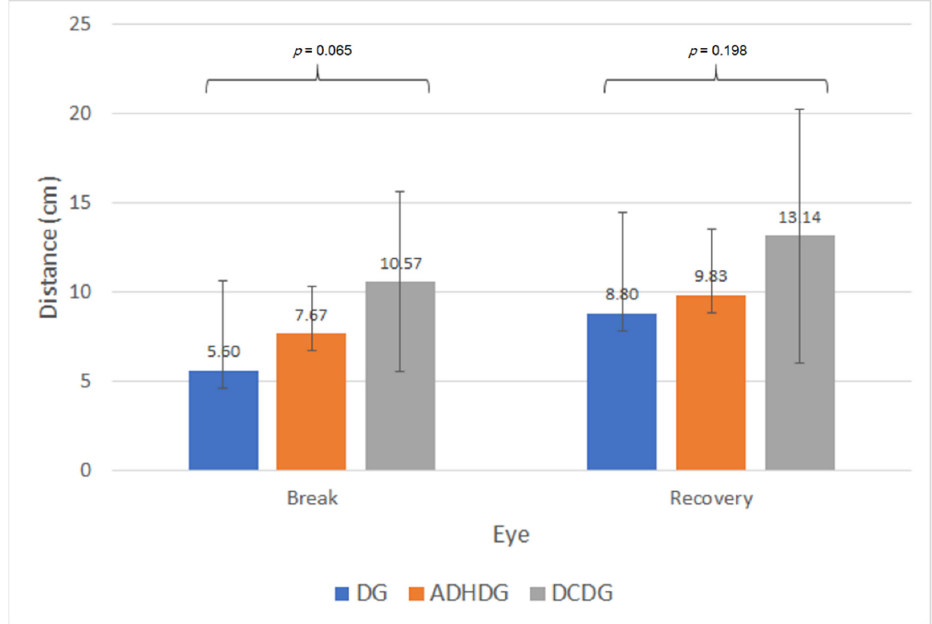
Figure 2. Mean values for the break and recovery points of the near point of convergence (NPC) in the subgroups of dyslexia (DG), attention deficit/hyperactivity disorder (ADHDG) and developmental coordination disorder (DCDG).